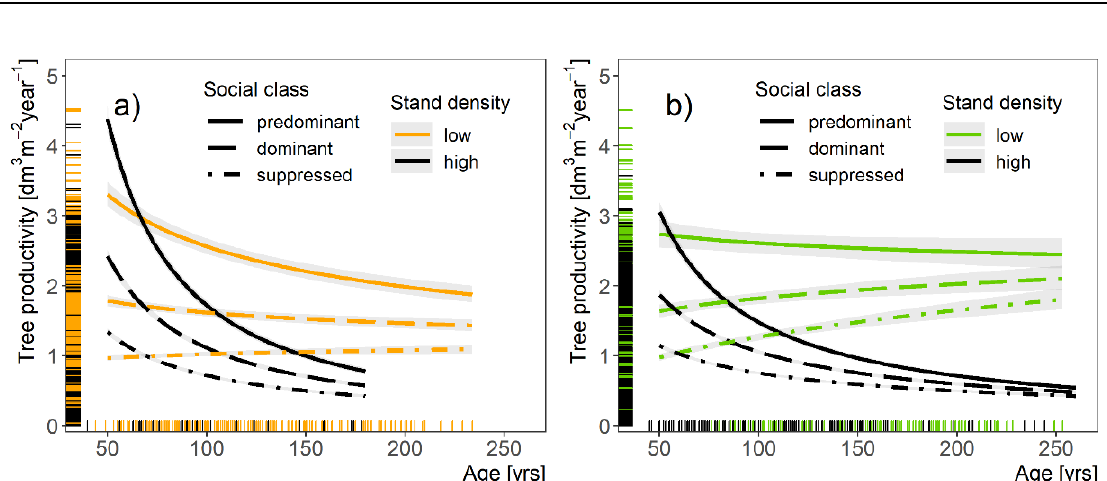
Figure 4. Productivity of oak trees growing in monospecific ( a ) and mixed species ( b ) stands as a function of Age, stand density and social class; low stand density = SDI of 100, high stand density = SDI of 350; rugs on the x-and y-axis indicate the observed values of age and tree productivity, respectively; all other variables were set to their mean.